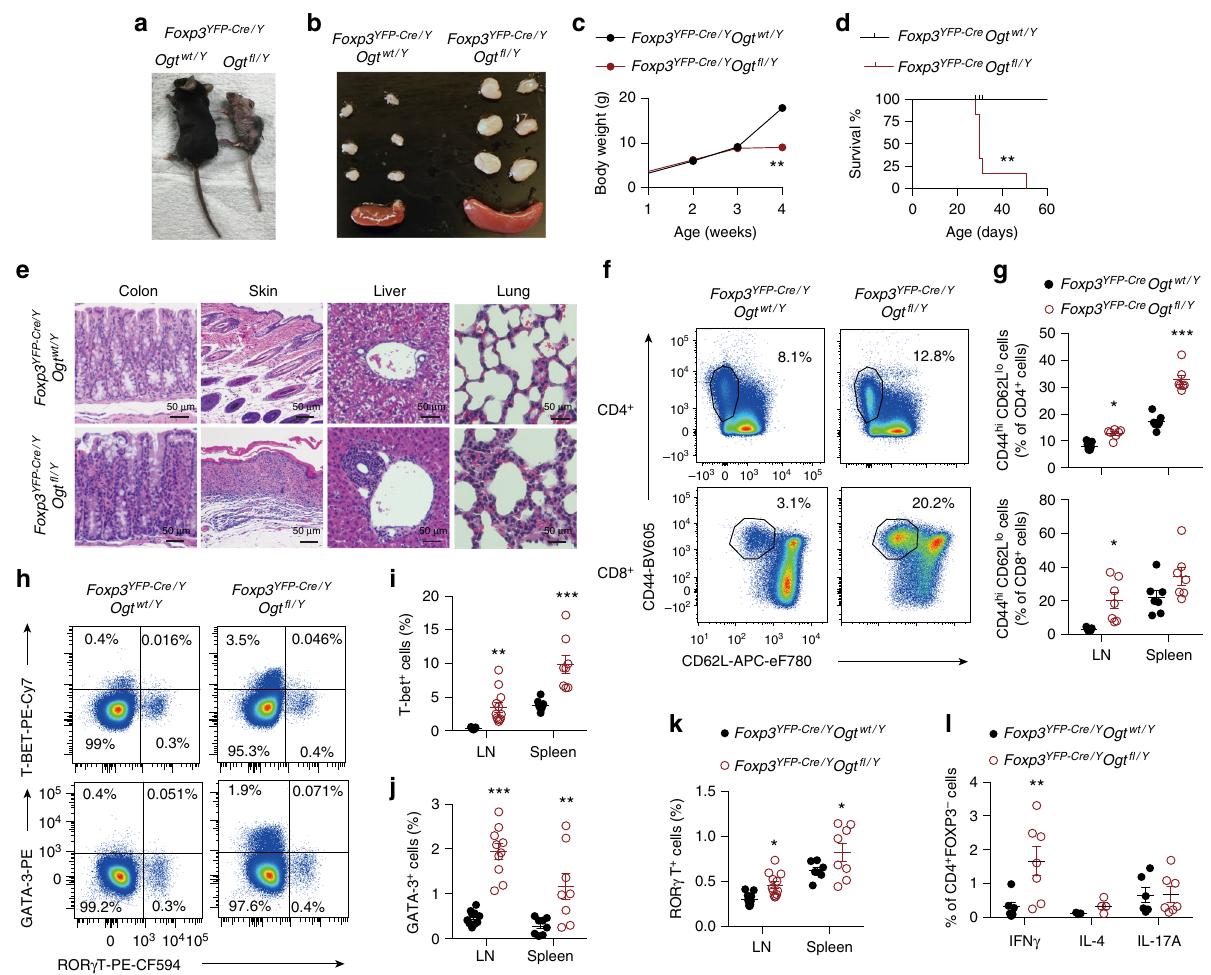
Fig. 3 OGT-de fi ciency in Treg cells leads to a scurfy phenotype in male mice. a , b Representative images of 4-week-old Foxp3 YFP-Cre/Y Ogt wt/Y and Foxp3 YFP-Cre/Y Ogt fl /Y mice ( a ) and peripheral LNs and spleen ( b ). c , d Body weight curve ( c , n = 5) and survival curve ( d , n = 6) of Foxp3 YFP-Cre/Y Ogt wt/Y and Foxp3 YFP-Cre/Y Ogt fl /Y mice. e Representative images of H&E staining of the colon, skin, liver, and lung from 4-week-old Foxp3 YFP-Cre/Y Ogt wt/Y and Foxp3 YFP-Cre/Y Ogt fl /Y mice. f , g Representative fl ow cytometry plots showing CD44 hi CD62L lo effector T cells among CD4 + (top) and CD8 + (bottom) T cells in the LNs ( f ) and quanti fi cation of the frequencies in the LNs and spleen of 2-week-old Foxp3 YFP-Cre/Y Ogt wt/Y and Foxp3 YFP-Cre/Y Ogt fl /Y mice, at least n = 6 each group ( g ). h – k Representative fl ow cytometry plots showing T-BET + , GATA3 + and ROR γ T + cells among CD4 + T cells in the LNs ( h ) and quanti fi cation of the frequencies of T-BET + cells ( i ), GATA3 + cells ( j ) and ROR γ T + cells ( k ) in the LNs and spleen of 2-week-old Foxp3 YFP-Cre/Y Ogt wt/Y and Foxp3 YFP-Cre/Y Ogt fl /Y mice were shown, n = 8 each group. l Frequencies of IFN γ + , IL-4 + and IL-17A + cells in CD4 + FOXP3 - T cells stimulated with PMA/lonomycin in the LNs of 2-week-old Foxp3 YFP-Cre/Y Ogt wt/Y and Foxp3 YFP-Cre/Y Ogt fl /Y mice, at least n = 3 each group. Data are shown as mean ± s.e. m. * p < 0.05; ** p < 0.01; *** p < 0.001 by unpaired student ’ s t -test ( c , g , and i – l ) and Kaplan-Meier Analysis ( d ) insight into the OGT-dependent transcriptional program in Treg both OGT-suf fi cient (YFP − ) and OGT-de fi cient (YFP + ) Treg cells, we performed RNA-sequencing of isolated YFP + Treg cells cells because of random inactivation of the X chromosome. from Foxp3 YFP-Cre/wt Ogt wt/ fl and healthy Foxp3 YFP-Cre/wt Ogt fl / fl Nevertheless, we could observe signi fi cant reductions in the females to avoid secondary changes in gene expression caused by abundance of CD44 hi CD62L lo , KLRG1 + , PD-1 + , CD73 + , and CD103 + eTreg cells when comparing YFP + OGT-de fi cient to in fl ammation. We were able to identify 269 differentially YFP - OGT-suf fi cient cells in the same Foxp3 YFP-Cre/wt Ogt fl / fl mice expressed genes including 154 downregulated and 115 upregu- lated with p values less than 0.01 (Fig. 6a). eTreg cell markers (Fig. 5e-i). Similar reductions in eTreg signature molecules could such as klrg1 , S100a4 , Gzmb , and Ccr2 were downregulated by the be observed when comparing YFP + Treg cells between Foxp3 YFP- Cre/wt Ogt fl / fl and Foxp3 YFP-Cre/wt Ogt wt/ fl mice (Supplementary loss of O-GlcNAcylation (Fig. 6a). The transcription factor B Fig. 6E-I). These data indicate a cell-intrinsic loss of effector lymphocyte-induced maturation protein (BLIMP)-1 is common molecules in OGT-de fi cient Treg cells. to all eTreg cells 38 , and we found that BLIMP-1-upregulated genes were enriched in OGT-suf fi cient Treg cells, while BLIMP- Attenuated IL-2/STAT5 signaling in OGT-de fi cient Treg cells . 1-downregulated genes were enriched in OGT-de fi cient Treg cells (Fig. 6b, c), suggesting that OGT maintains a transcriptional program similar to that of BLIMP-1 + eTreg cells. Ingenuity Pathway Analysis (IPA) identi fi ed 9 potential upstream regulators which were all predicted to be inhibited, and the top one was IL-2 NATURE COMMUNICATIONS| (2019) 10:354